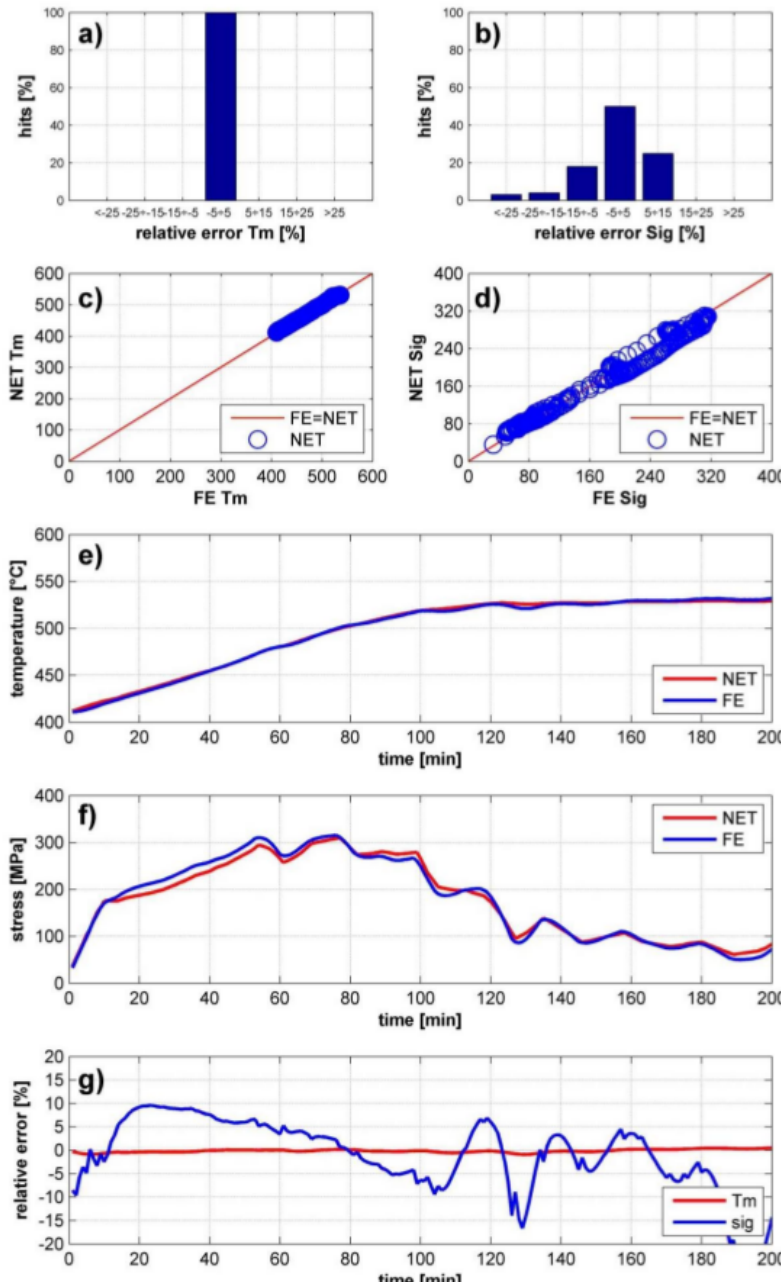
Figure 9: Result of neural network tests for warm 2